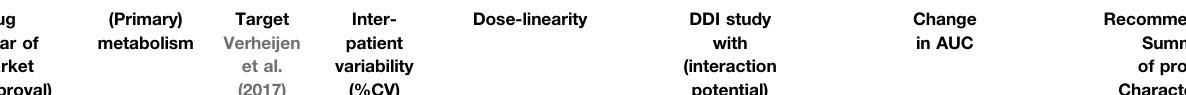
TABLE 2 | ( Continued ) Detailed overview of the results of DDI studies performed with the reviewed oral oncolytic